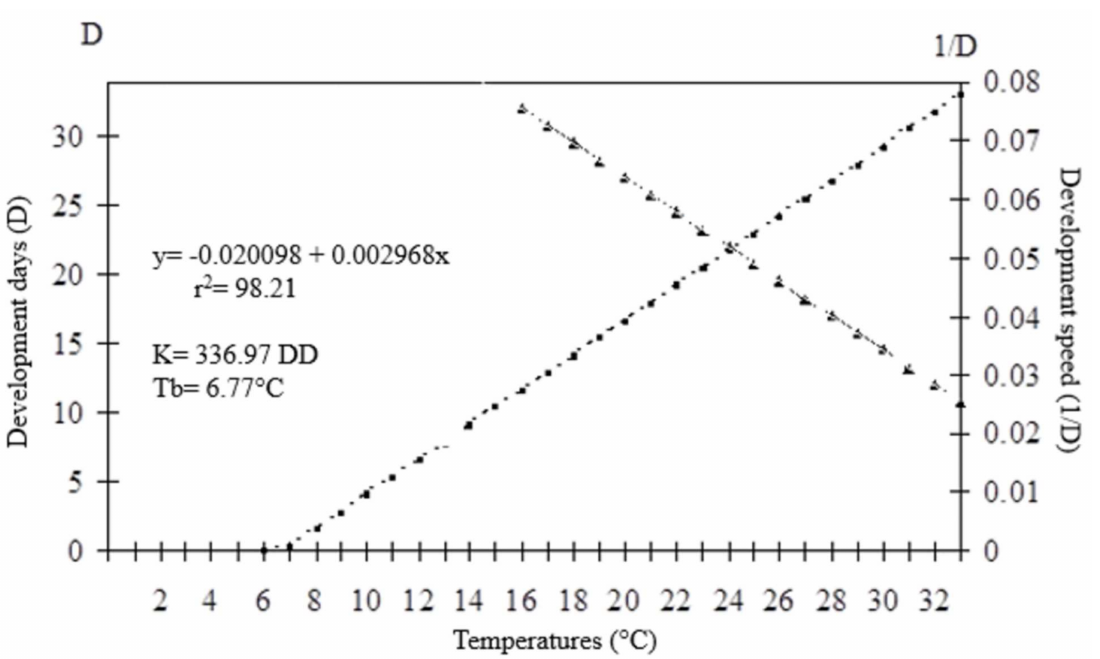
Figure 4. Sex ratio (%) (mean ± EP) of Telenomus podisi in Euschistus heros eggs at different temperatures. 3.3. Thermal Requirements and Estimate of the Number of Generations of O. submetallicus and T. podisi The thermal requirements of O. submetallicus parasitizing E. heros eggs were deter- mined based on the model y = (1/D) = − 0.0020098 + 0.002968x (r 2 = 0.98), with values for the lowest temperature threshold (Tb) estimated as 6.77 ◦ C and thermal constant (K) esti- mated as 336.97 degree-days (DD) (Figure 5). For T. podisi , y = (1/D) = − 0.034174 + 0.003670x (r 2 = 0.99), the lowest temperature threshold (Tb) was 9.31 ◦ C and the thermal constant (K) was determined as 272.46 degree-days (DD) (Figure 6).